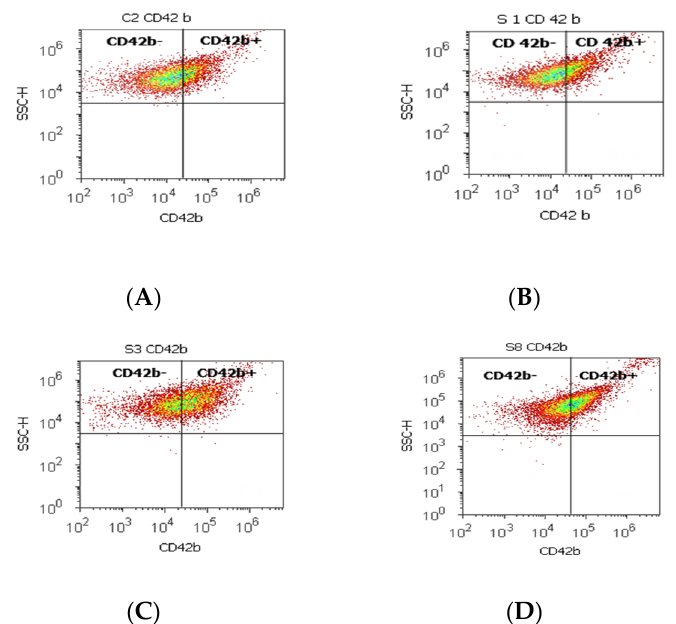
Figure 3. Integrin mediation of platelet aggregation to tumoral and endothelial cells by highlighting the positive and negative glycoprotein populations (CD42b-/CD42b+) with CD 42b-PE stain. CD42b+ population: ( A ) 25.80 %; ( B ) 16.79%; ( C ) 41.10%; ( D ) 39.74%; CD42b- population: ( A ) 73.08%; ( B ) 82.88%; ( C ) 57.58%; ( D ) 57.23%. Legend : ( A ) non-malignant prostate tissue adjacent to nodular hyperplastic tissue; ( B ) adenoleiomyoma prostate tissue, chronic inflammation hyperplasia; ( C ) malignant prostate tumor tissue; ( D ) benign prostatic tissue hyperplasia. Cell viability had increased values without significant differences on PCa and control tissue samples (81.30 ± 16.42; 86.95 ± 5.75, p > 0.05, Table 4, Figure 4), but the obtained results for BPH cases showed a significantly lower value of this on BPH tissue samples reported to controls (BPH 64.26 ± 22.68 vs. 86.95 ± 5.75, p < 0.05). Necrosis presented a statistical increase of values in BPH cases compared with control cases (BPH 26.76 ± 6.32 vs. C 13.04 ± 5.76), and incipient cell apoptosis had a statistical increase in PCa tissue samples (7.08 ± 10.46) reported to non-malignant adjacent tissue samples (0.10 ± 0.01, p < 0.05, Table 4, Figure 4, Appendix D). Table 4. Cell apoptosis at prostate adenocarcinoma and benign prostatic hyperplasia cases reported to control cases. Number